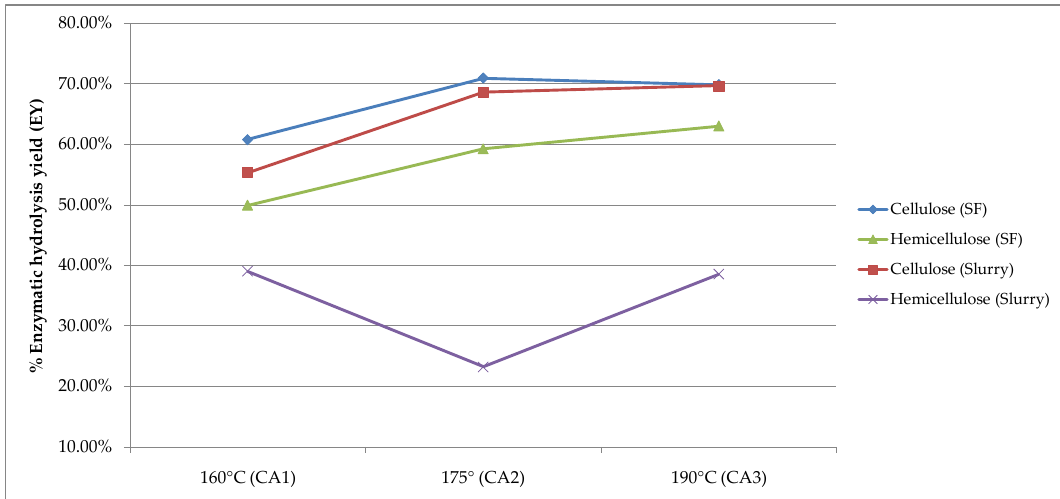
Figure 4. Enzymatic hydrolysis yields of SF and